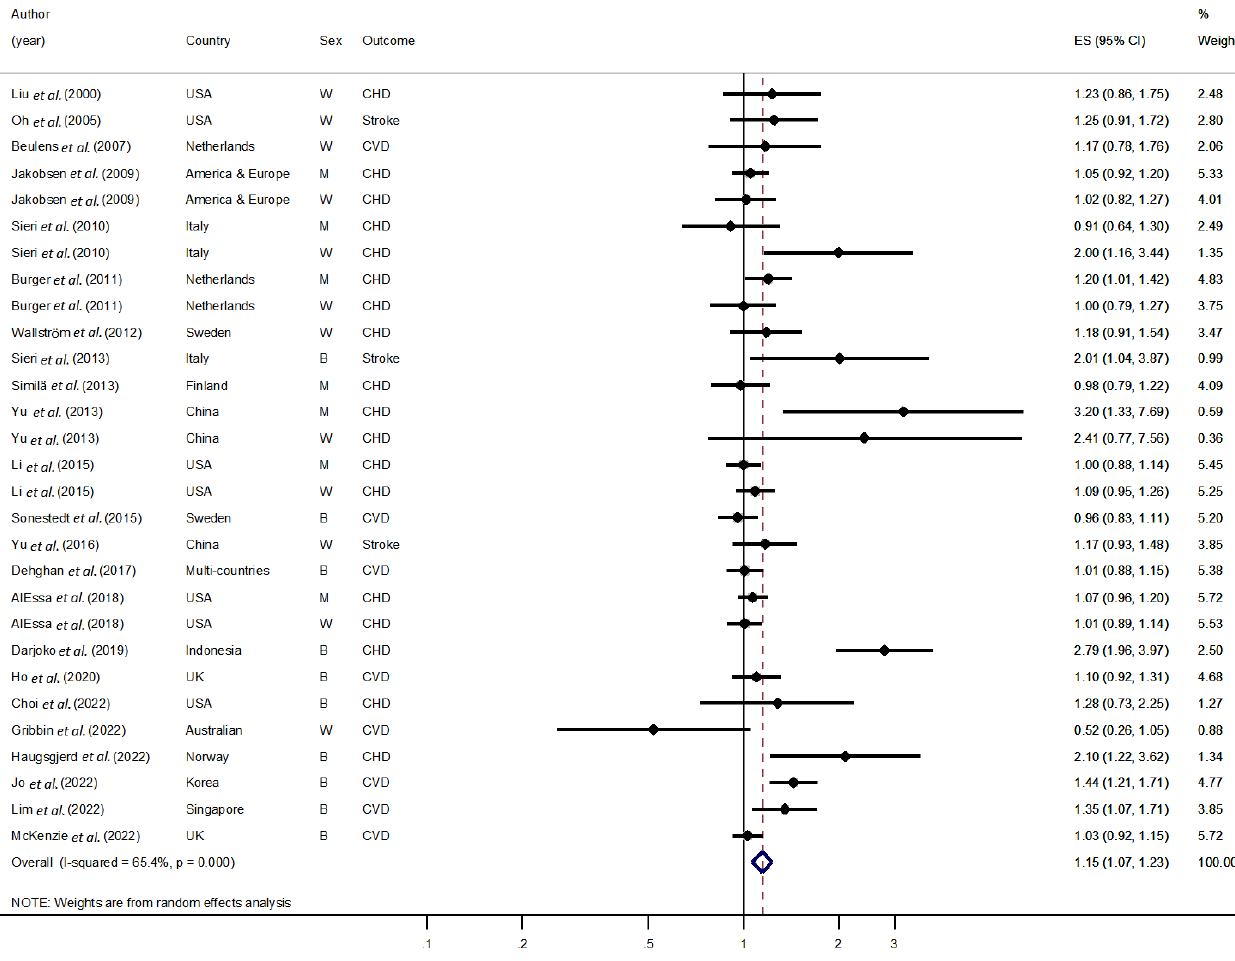
Figure 1. Forest plot of the association between carbohydrate intake and cardiovascular disease. ES, effect size; CVD, cardiovascular disease; CHD, coronary heart disease; W, women; M, men; USA, United States of America; UK, United Kingdom. [6,12–18,25–39]